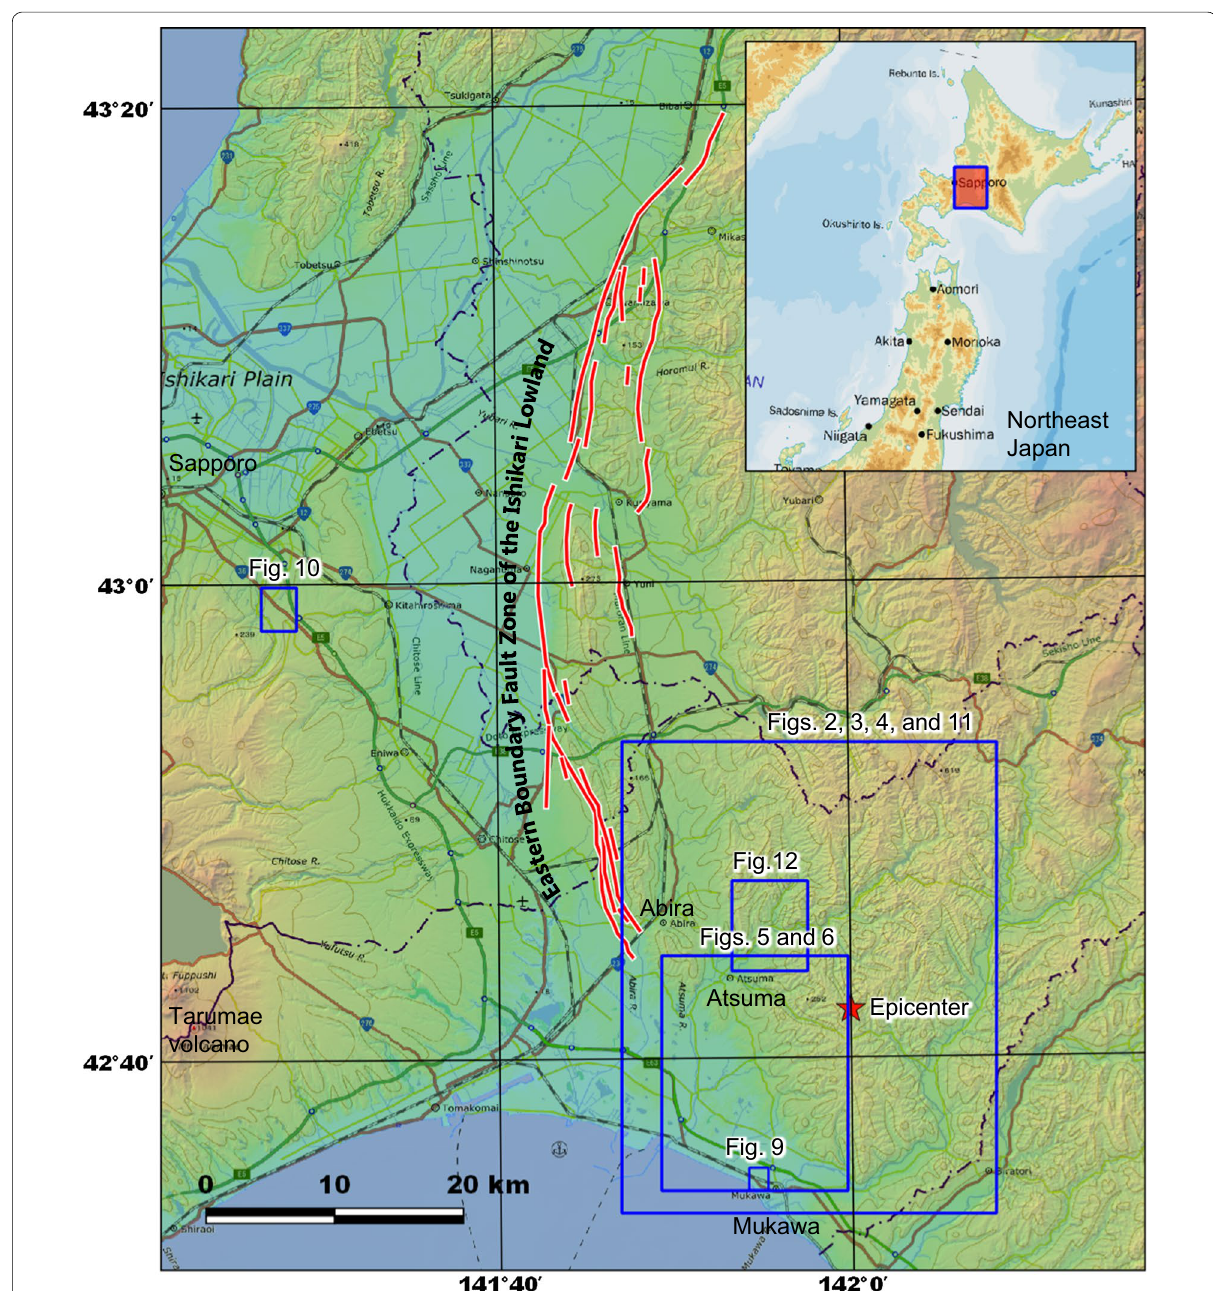
Fig. 1 Study area (location shown by inset) with important towns and cities labeled. Red lines show the Eastern Boundary Fault Zone of the Ishikari Lowland (Ikeda et al. 2002). Rectangles show the area of other figures. The red star shows the epicenter of the 2018 Hokkaido Eastern